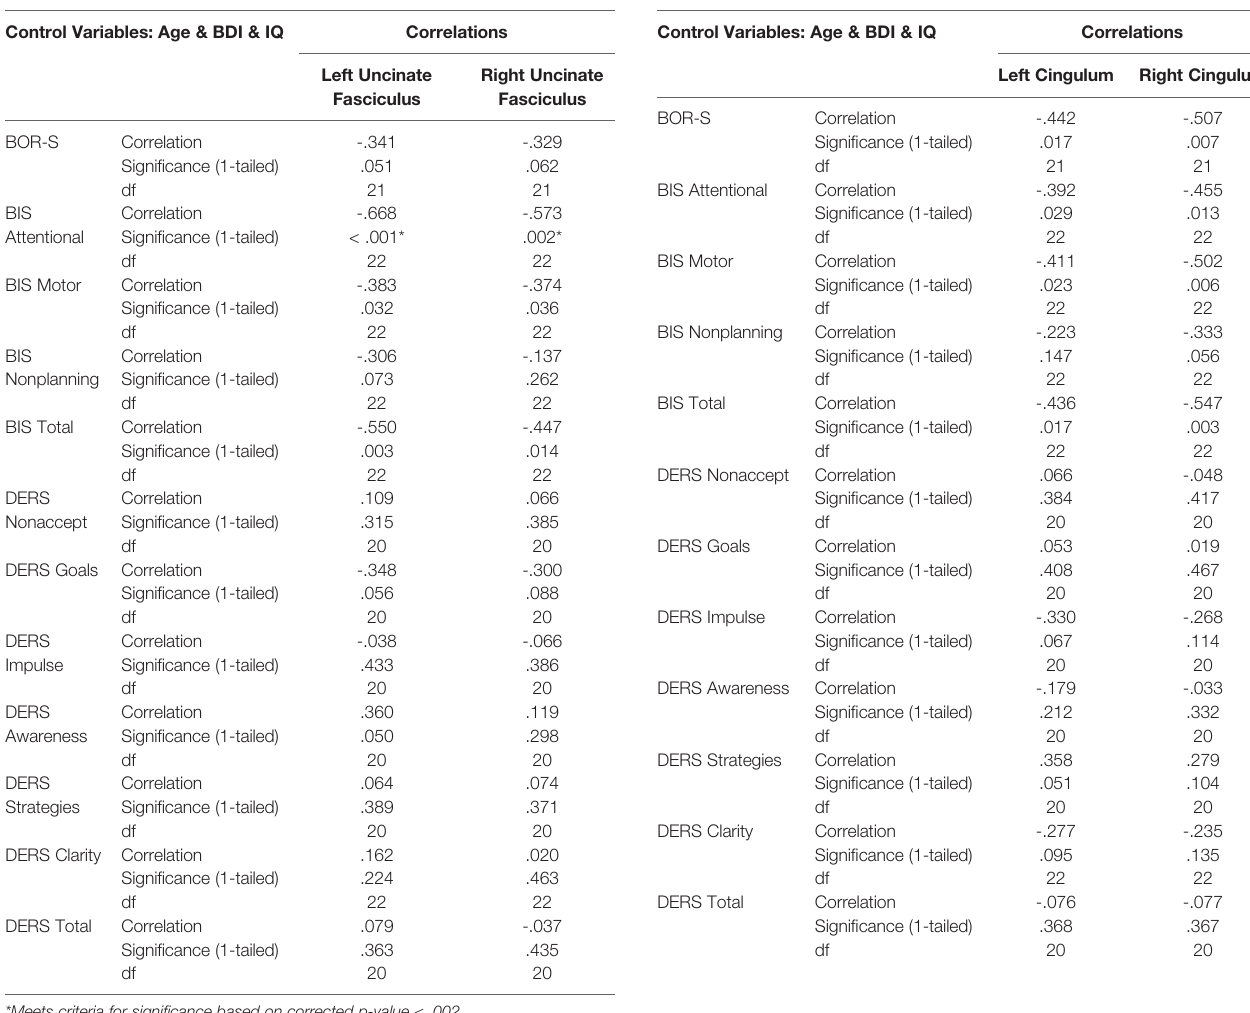
TABLE 3 | Self-regulation and cingulum